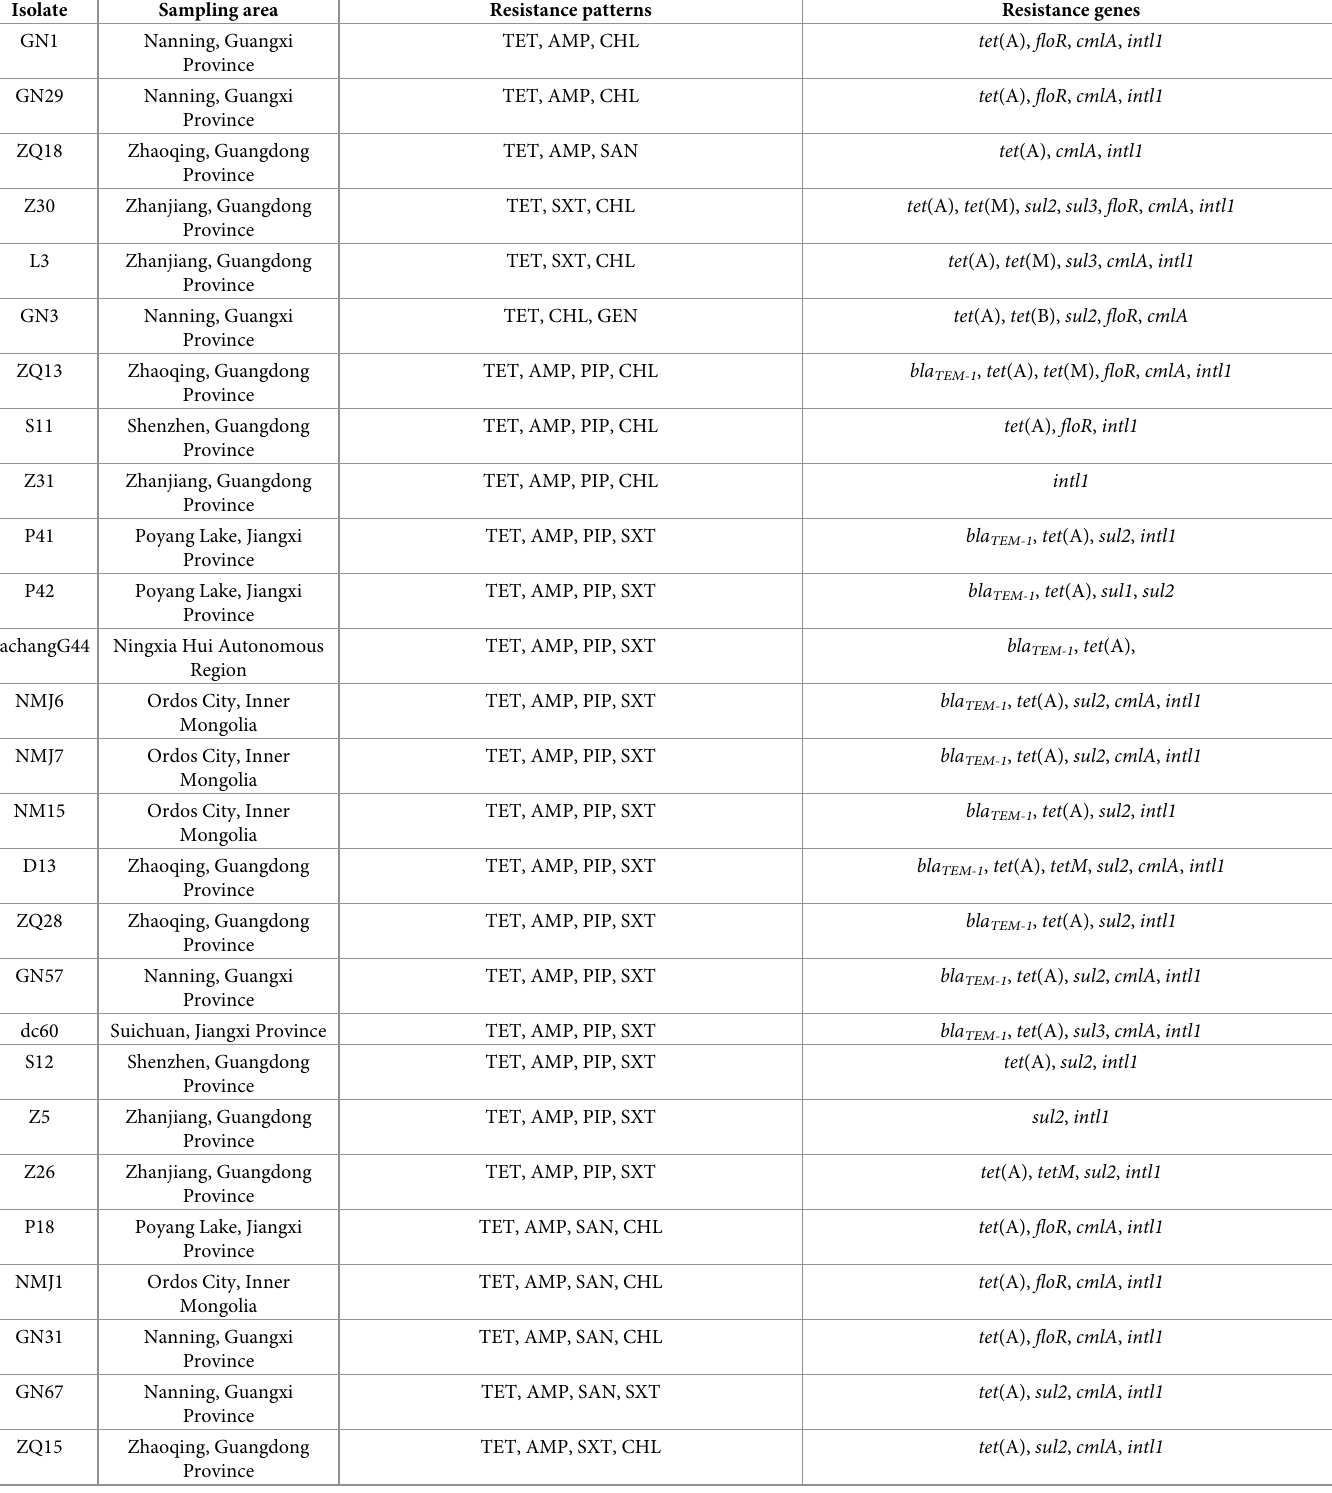
Table 3. Phenotypes, ARGs, and integrase genes of the E . coli isolates from migratory wild birds.